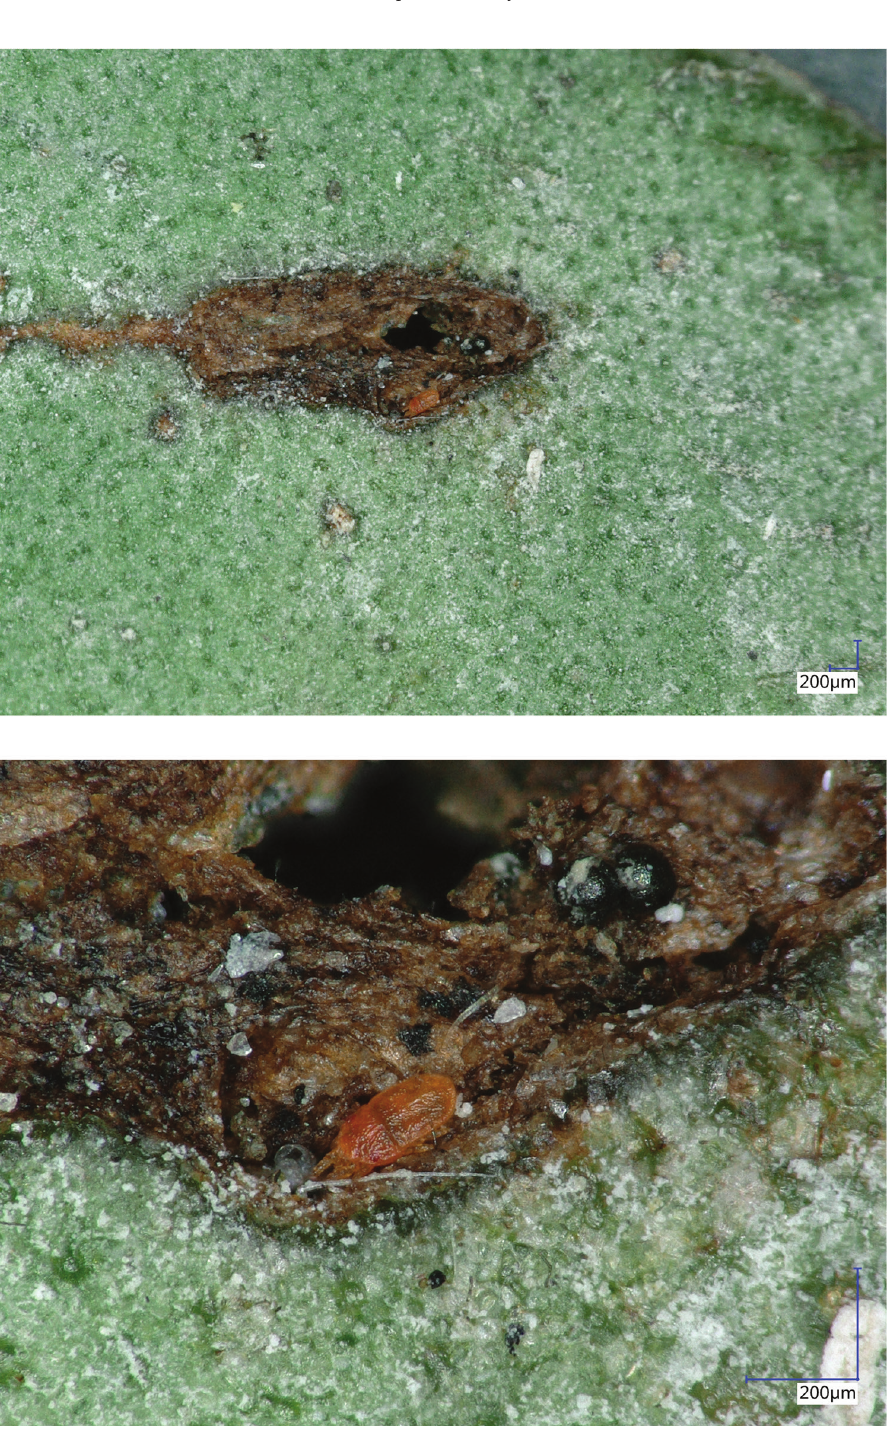
Figure 27. Photos of the female of Aegyptobia bozaii sp. n.,